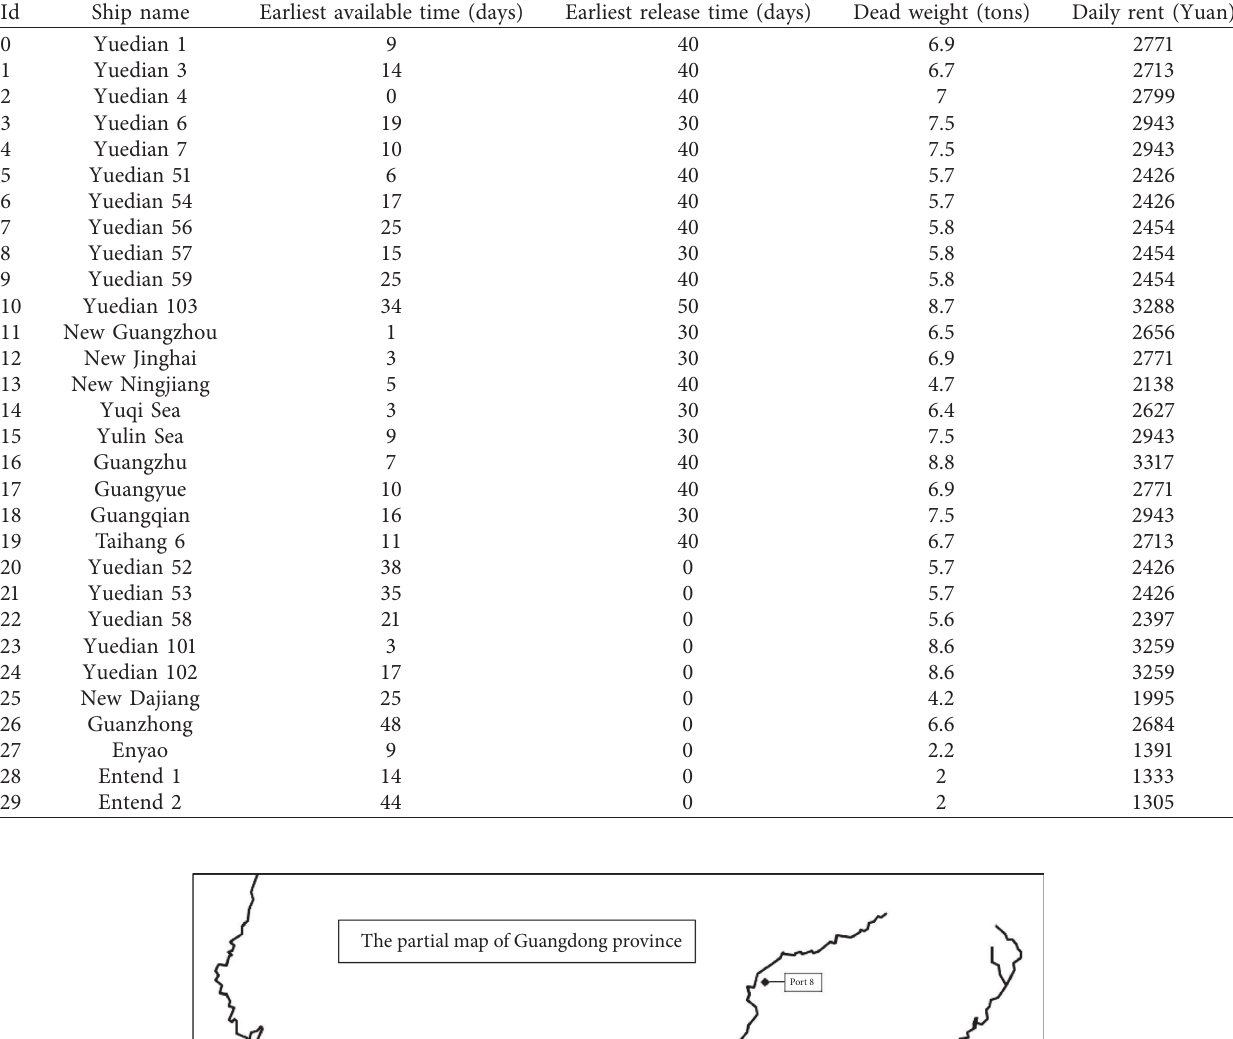
Table 2: The transport demand and fleet data of a Chinese thermal power generation group from May to June 2015. Id